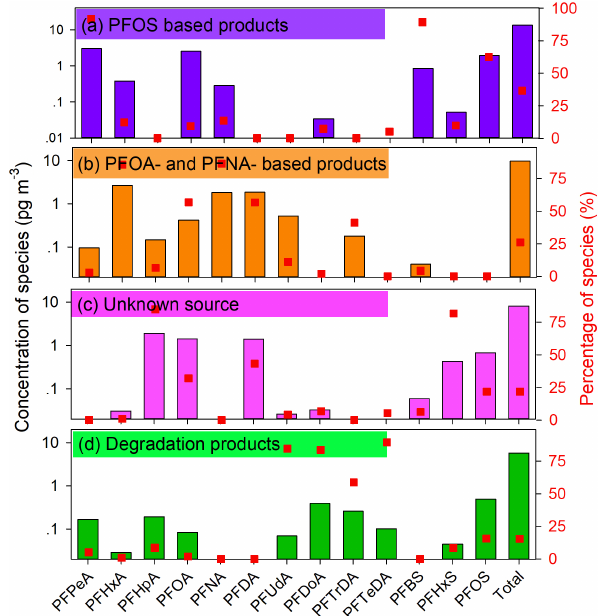
Figure 4. Factor profiles of PFAAs extracted by the PMF